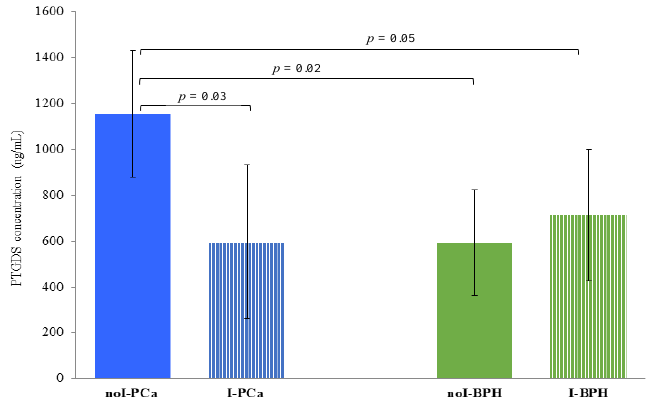
Figure 4. PTGDS quantification by ELISA. Protein concentrations are expressed as mean ± SD. Significant comparisons are highlighted by connecting lines, each showing the p -value obtained by Student’s t -test ( p ≤ 0.05 are considered as statistically significant).